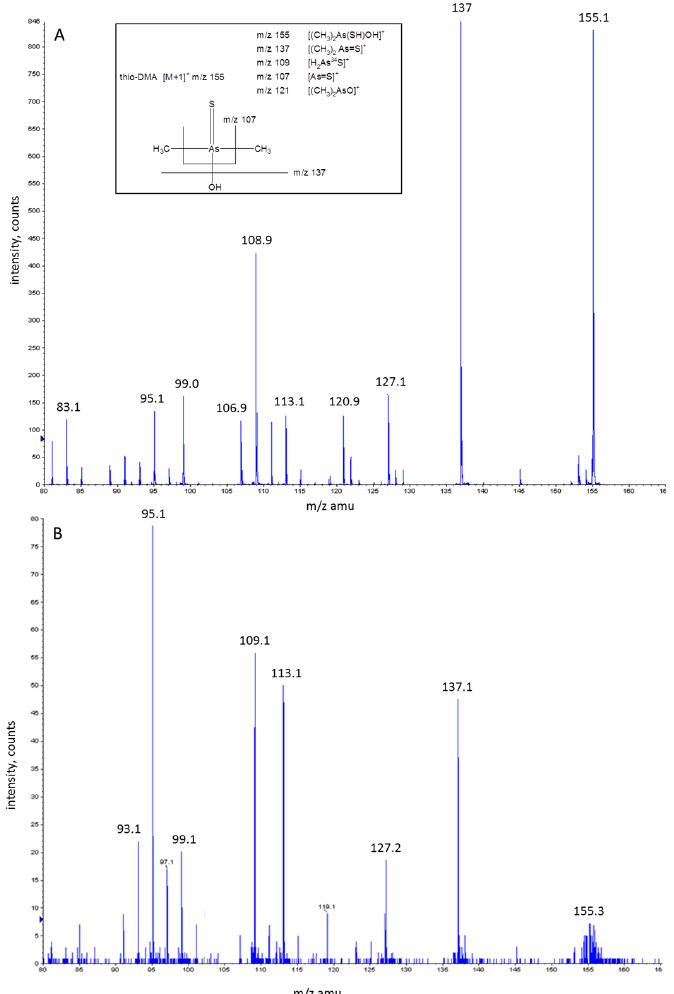
Figure 4. The chemical structure of thio-DMA, with suggested fragment ions when measured in positive ion mode by ESI-QqTOF-MS/MS within the two ESI-QqTOF-MS/MS spectra from product ion scans of m/z 155, when infusing ( A ) Thio-DMA standard at an approximate concentration of 1600 µ g · L − 1 . ( B ) Fraction of a urine sample containing peak 1 with blank urine correction from a urine sample not containing peak